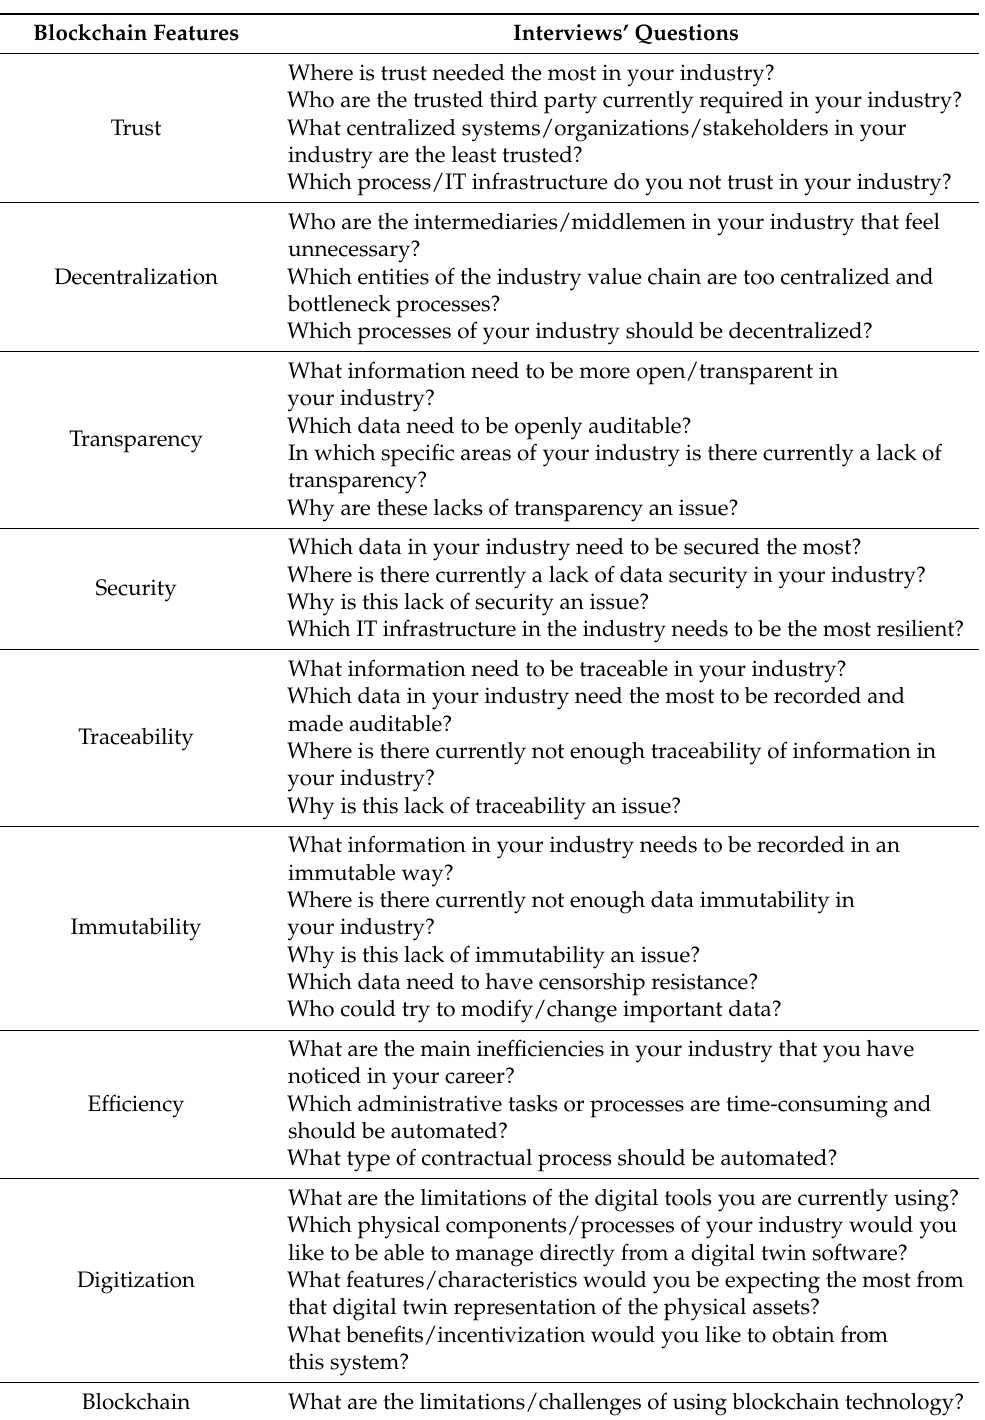
Table 5. Interviews’ questions covering nine features of